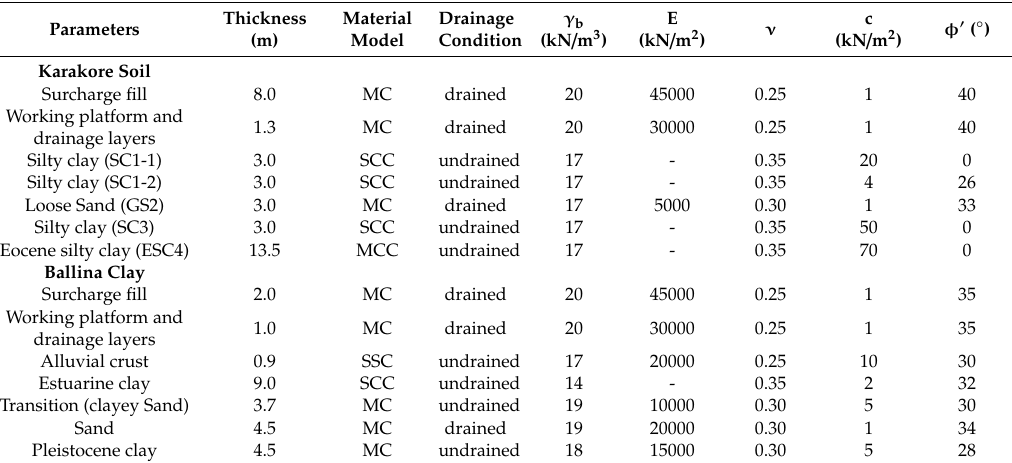
Table 2. Basic input parameters for FE modeling.